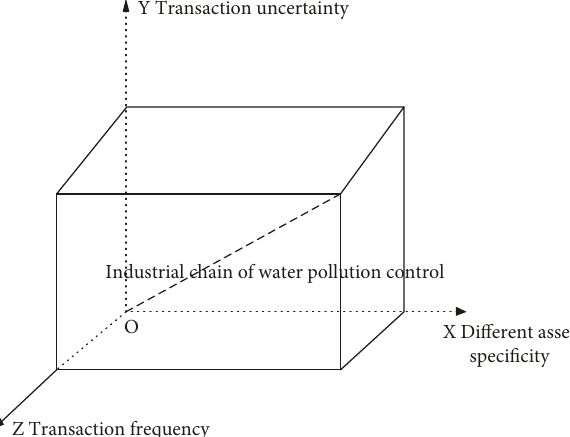
Figure 2: The vertical cooperation model of the water pollution control industry chain from the perspective of transaction